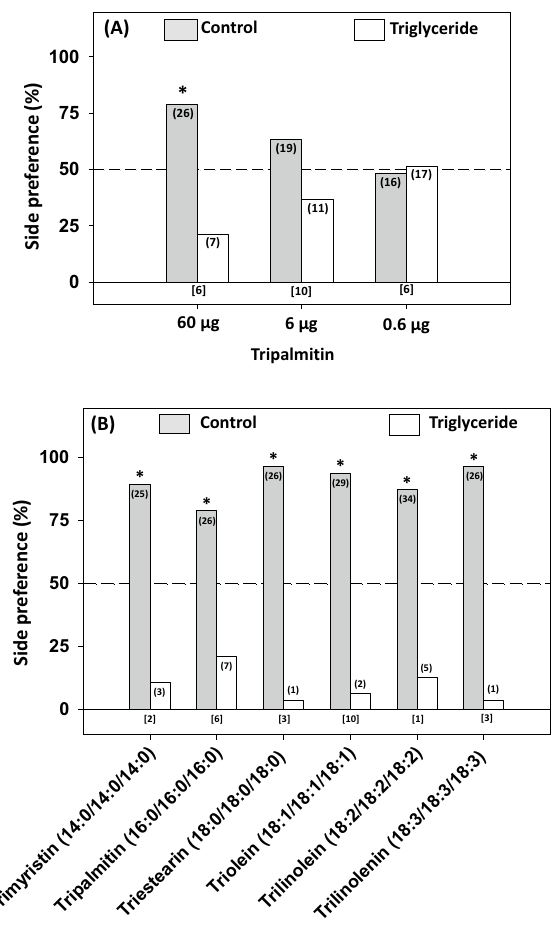
Figure 7. Response of bed bugs to various lipids. ( A ) Bed bugs responded to tripalmitin in a dose-dependent manner. ( B ) Various triglycerides (at 60 µg) of different compositions prevented bed bug arrestment. An asterisk (*) indicates a significant preference for one side of the two-choice assays (Chi-square test, P < 0.05). The number of bed bugs that responded is indicated in parentheses for each choice, and the number of bed bugs that did not respond (did not contact either of the two shelters) is indicated in brackets below each set of choices for each